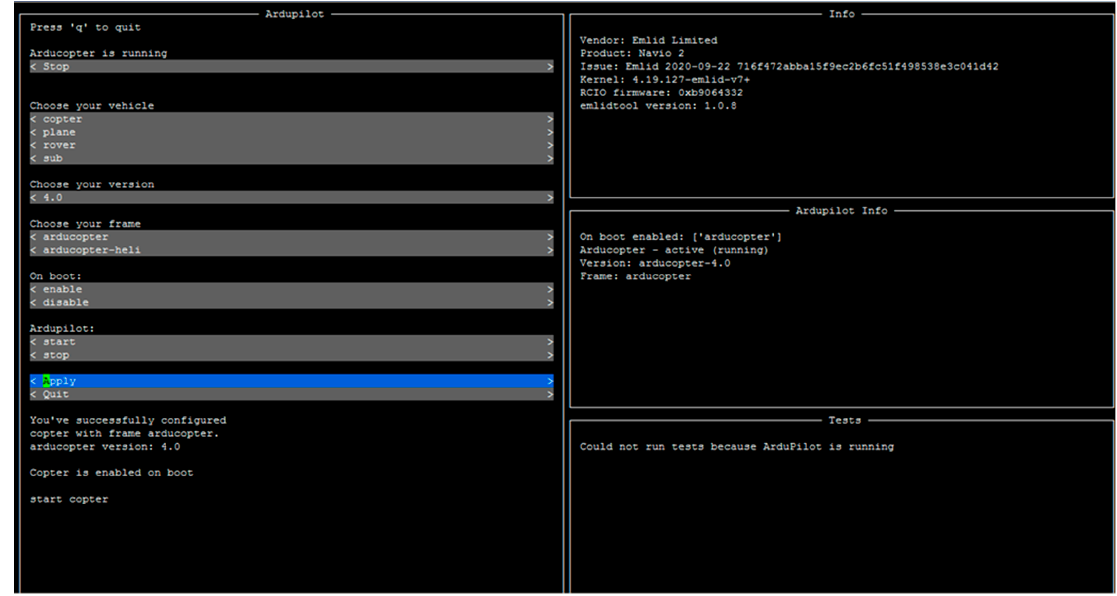
Figure 5. ArduPilot configuration details.